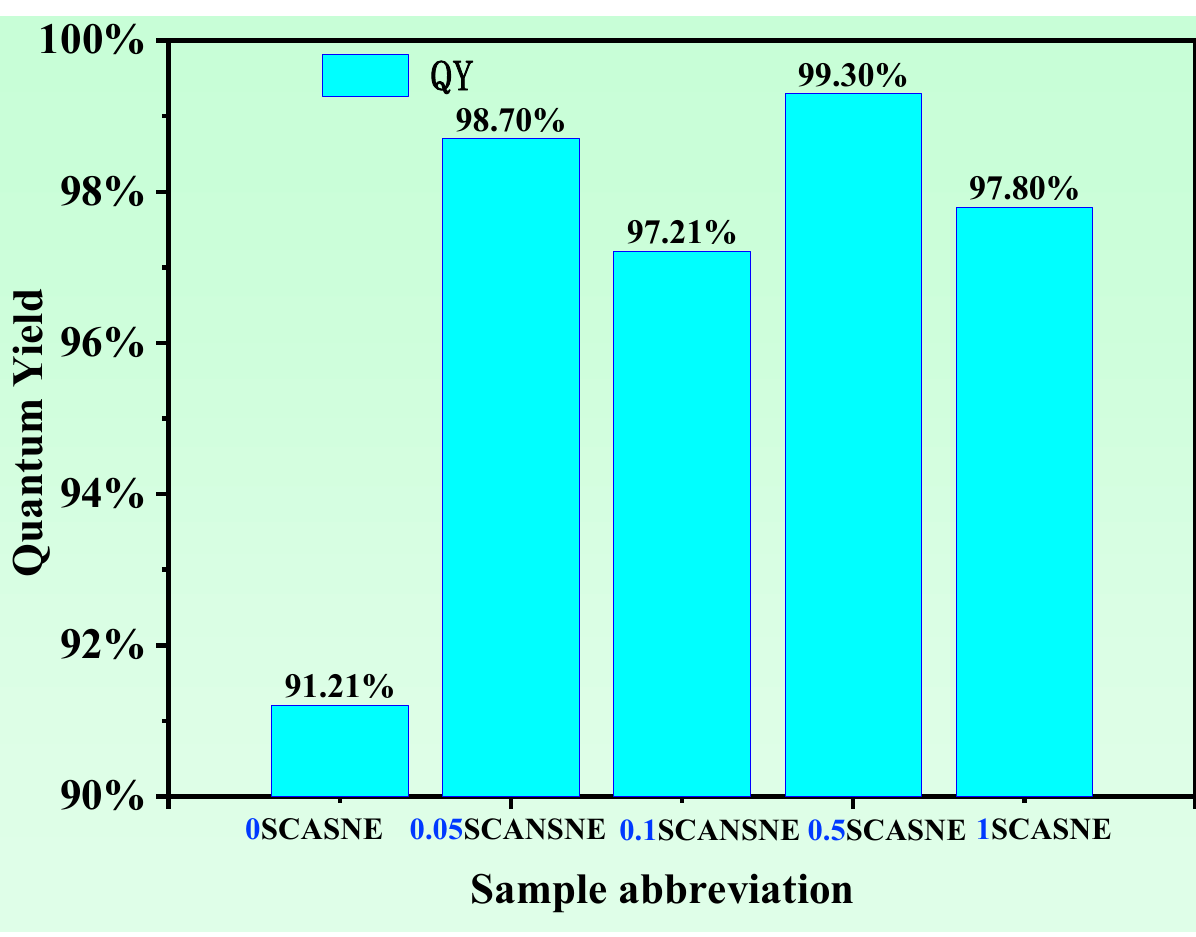
Figure 5. Quantum yield of x SCASNE phosphor ceramics ( x = 0, 0.05, 0.1, 0.5 and 1) and the inset screenshot of the 0.5SCASNE-ceramic test curve.